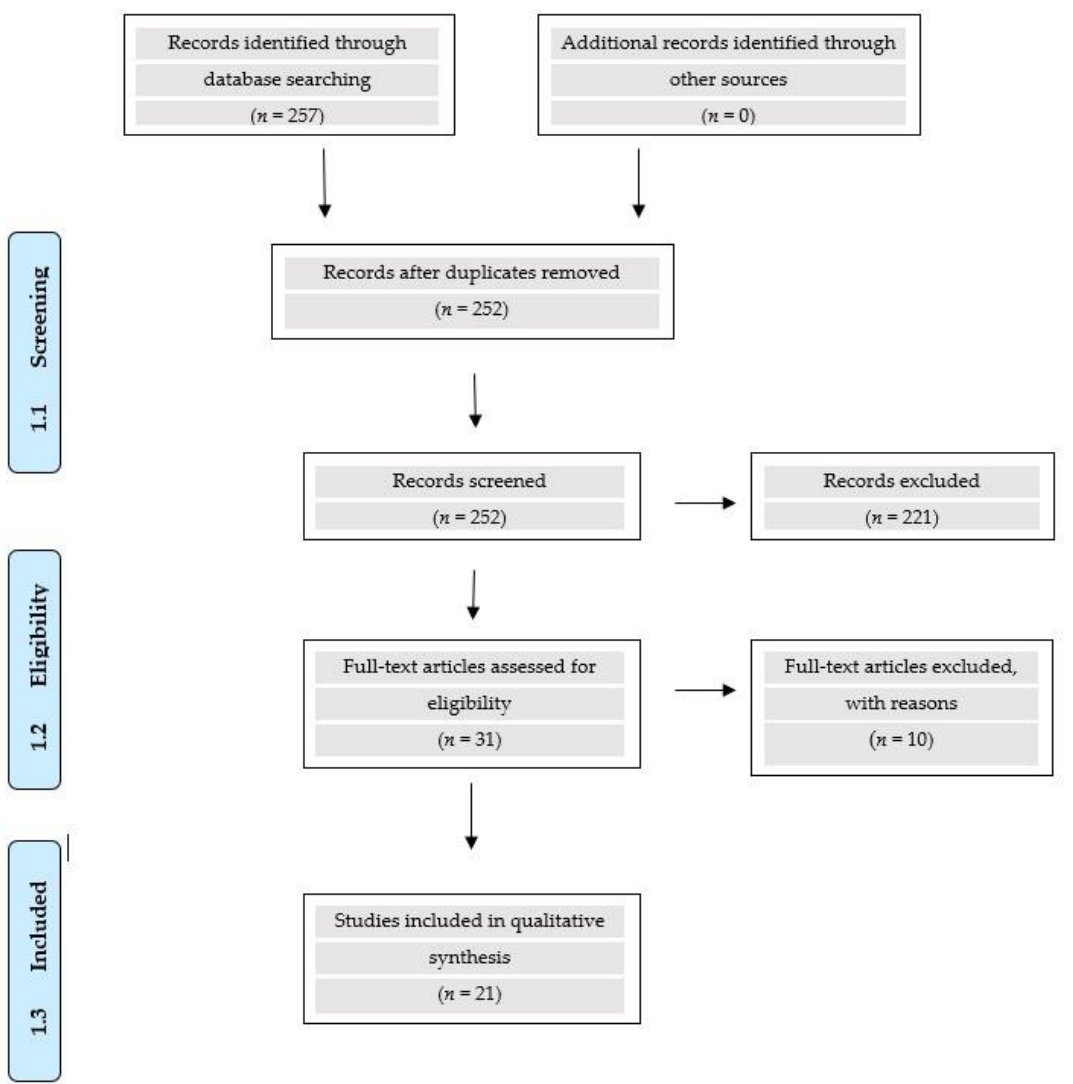
Figure 1. PRISMA Flow Diagram. Table 4. Number of studies excluded with reasons for approved trastuzumab biosimilars.